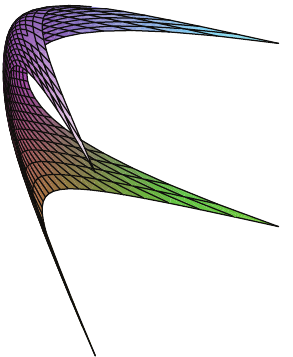
Figure 5: The catenoid of the 5th kind.